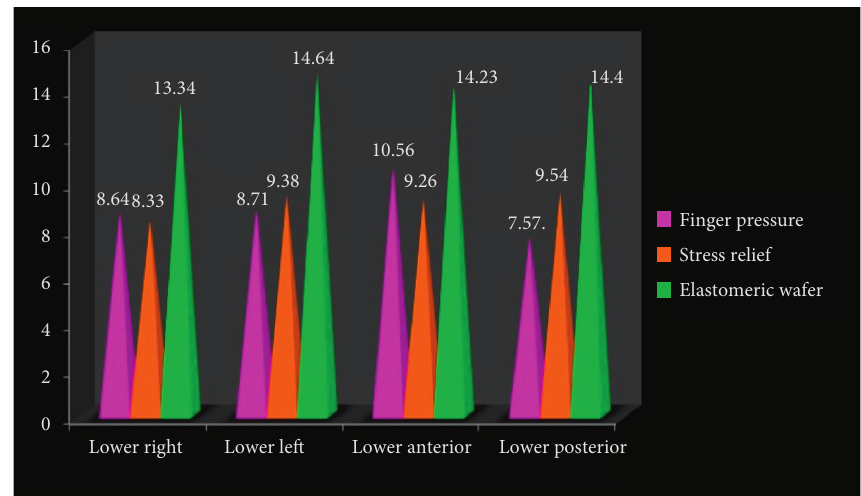
Figure 6: Median score for VAS for Lower quadrant.